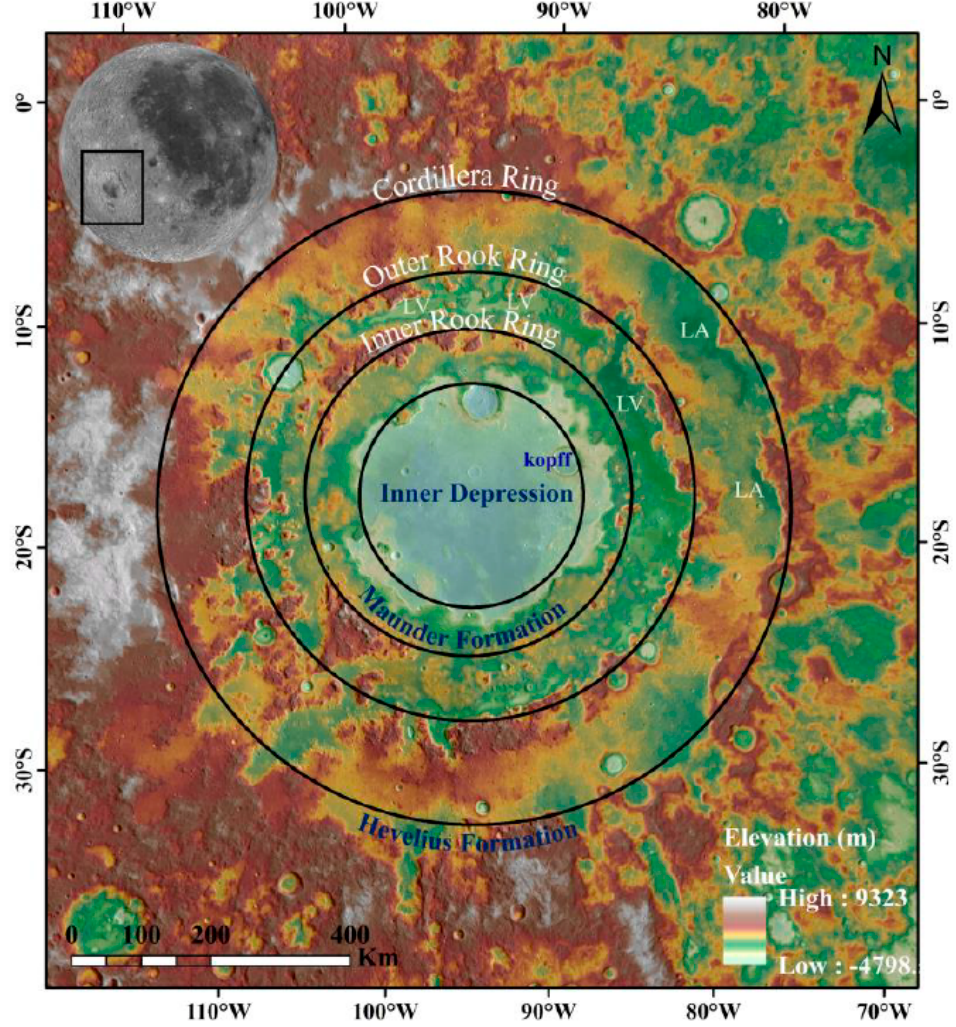
Figure 1. The inset shows a Lunar Reconnaissance Orbiter Camera (LROC)-Wide Angle Camera (WAC) map with the Mare Orientale of the Moon highlighted by the black box. Based on the research of Whitten et al. (2011), the Orientale basin is shown with the main rings and labelled deposits in the SLDEM data (~59 m/pixel).